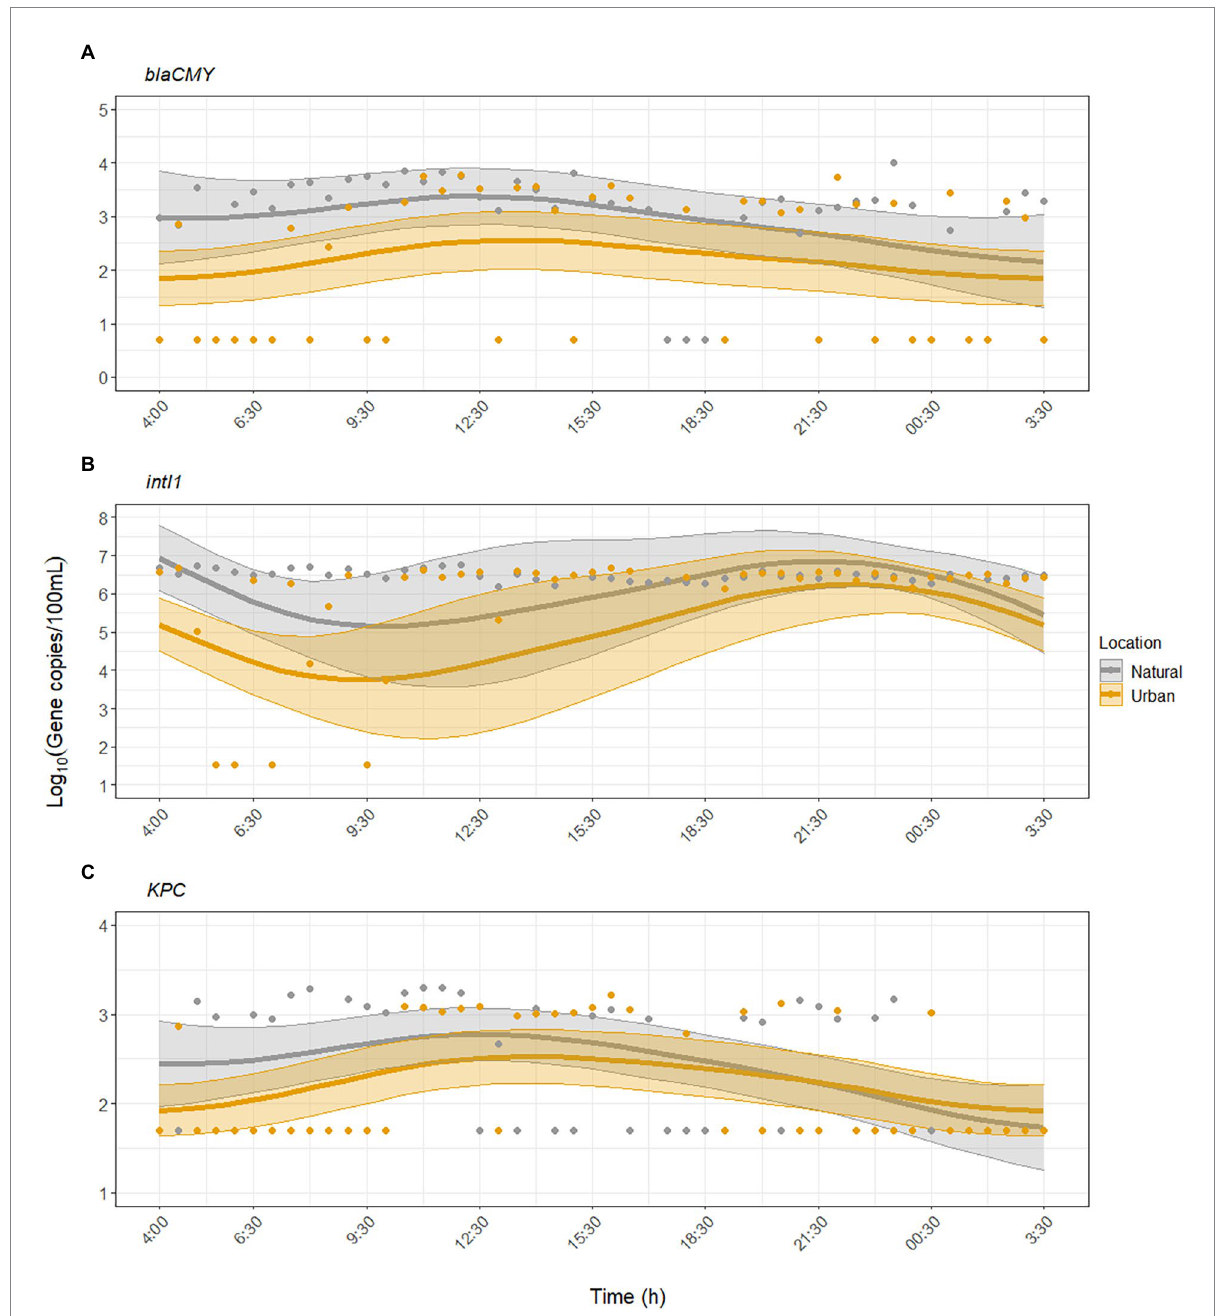
FIGURE 3 Dynamics of antibiotic resistance-associated genes (A) blaCMY , (B) intI1 , and (C) KPC over the sampling period at the urban (Paces Ferry) and natural (Cochran Shoals) sites. Solid lines represent model predictions with 95% confidence intervals. The models for blaCMY and KPC do not include the effect of environmental factors. The model for intI1 includes the effect of water temperature, pH, and turbidity. Points represent all collected samples, with undetected samples set to half the limit of detection (LOD) for each